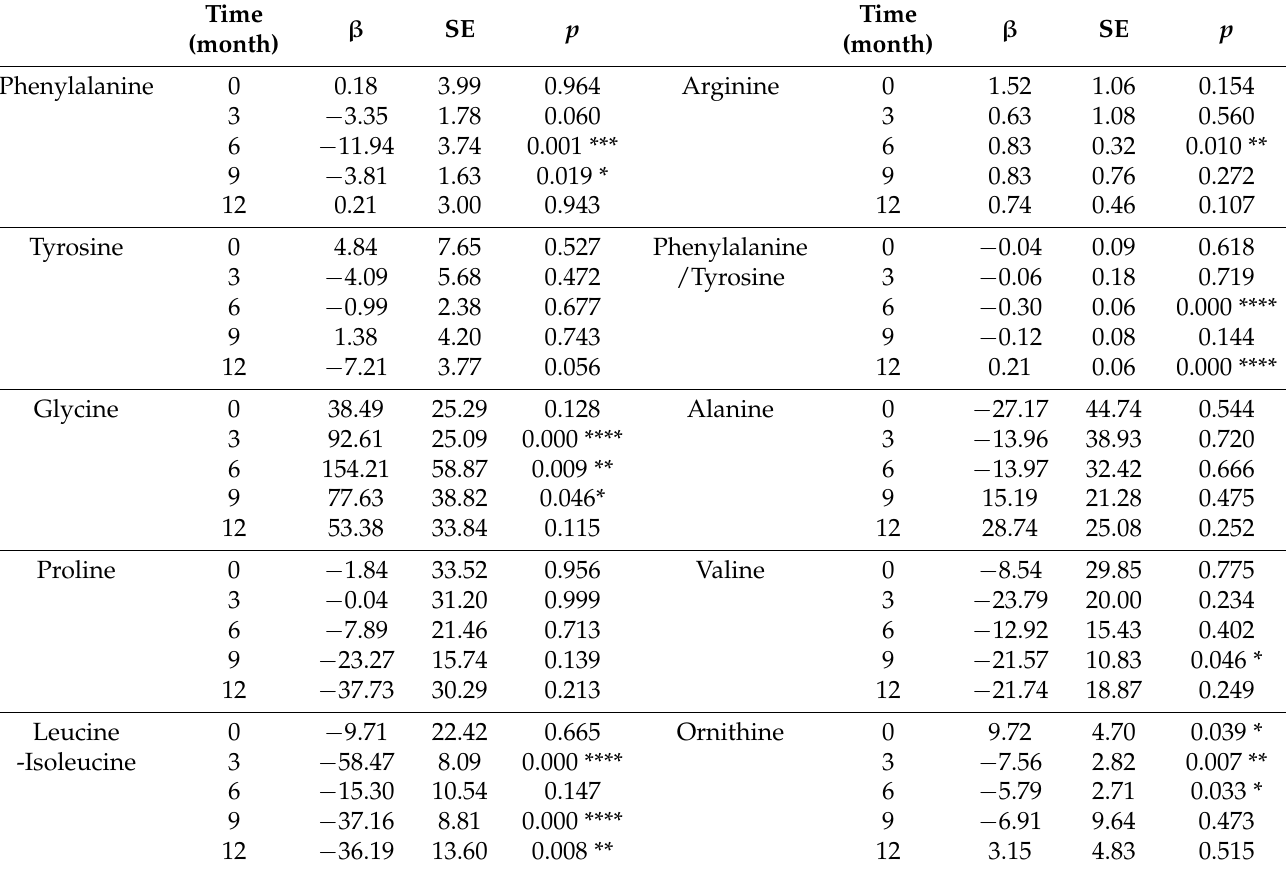
Table 3. Comparison of amino acids between responders and non-responders. Amino acids profile of responders ( n = 12) and non-responders ( n = 10). Group differences were analyzed by GEE after adjusting confounding effect of anticonvulsants. R : responders; NR :